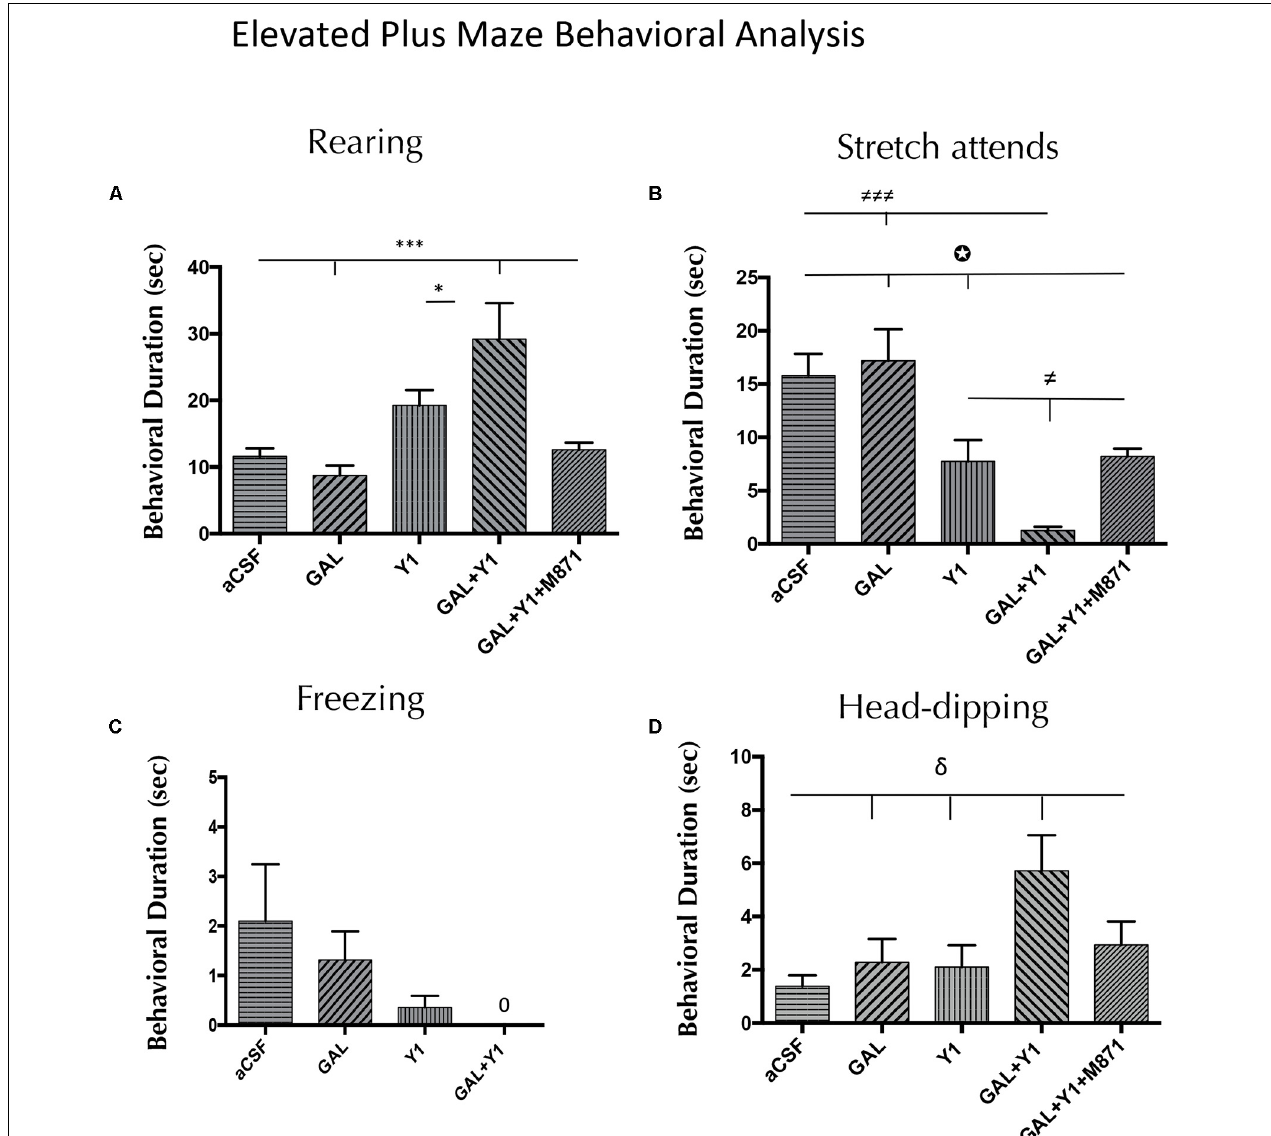
FIGURE 2 | Behavioral analysis mediated by Galanin (GAL) and the NPYY1R agonist in the elevated plus maze. The response induced by GAL on the NPYY1-mediated ethological behaviors is blocked by the GAL 2 receptor (GALR2) antagonist M871. Cumulative behavioral duration of rearings (A) , SAP (B) , freezing (C) and head-dipping (D) in this test. N = 6–8 animals in each group. Data represents mean ± SEM. Value for GAL+Y1+M871 group on freezing was 0. ∗ P < 0.05; ∗∗∗ P < 0,001; (cid:54)= P < 0.05; (cid:54)=(cid:54)=(cid:54)= P < 0.001; δ P < 0.05; P < 0.05 according to one-way ANOVA followed by Newman–Keuls Multiple Comparison Test. Inter-group comparisons are indicated by the lines above bars. GAL, Galanin 3 nmol; Y1 = NPY Y1 receptors agonist [Leu 31 -Pro 34 ]NPY 3 nmol; GAL+Y1, Coadministration of GAL and Y1; GAL+Y1+M871, Coadministration of GAL, Y1 and GALR2 antagonist M871 3